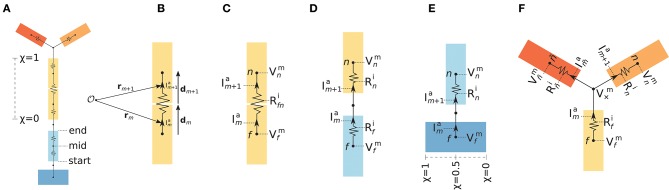
Axial currents in multicompartment neuron models. (A) Schematic illustration of sections (colored rectangles), segments and equivalent electric circuit of a simplified multicompartment neuron model. The relative length χ varies between 0 and 1 from start- to end-point of each section. (B) Axial current line element vectors (dm, dm+1) and corresponding midpoints (rm, rm+1) of axial currents (Ima,Im+1a) between two connected segments. (C) Axial currents (Ima,Im+1a), membrane potentials (Vfm,Vnm), and axial resistance (Rfni) in equivalent electric circuit for a parent segment f and child segment n in a single section. (D) Similar to panel B, but parent and child segments belong to two different sections. The total series resistance is here Rfi+Rni. (E) Illustration of the case where the child segment n is connected to a point χ = 0.5 on the parent section. For children connected at χ ∈ 〈0, 1〉 the voltage difference (Vnm-Vfm) is only across the child segment axial resistance Rni, but the (virtual) current from the node connecting the child start point to the parent midpoint Ima is still accounted for. (F) Illustration of axial currents at branch point between different sections of the morphology. The child segment n has one parent f and one sibling indexed by ñ, where V×m denotes the virtual membrane potential at the node connecting the parent end-point to the children start-points. Vñm is the voltage in the midpoint of the sibling segment, while Rñi and Im~a denotes the axial resistance and current between the sibling midpoint and the branch point.